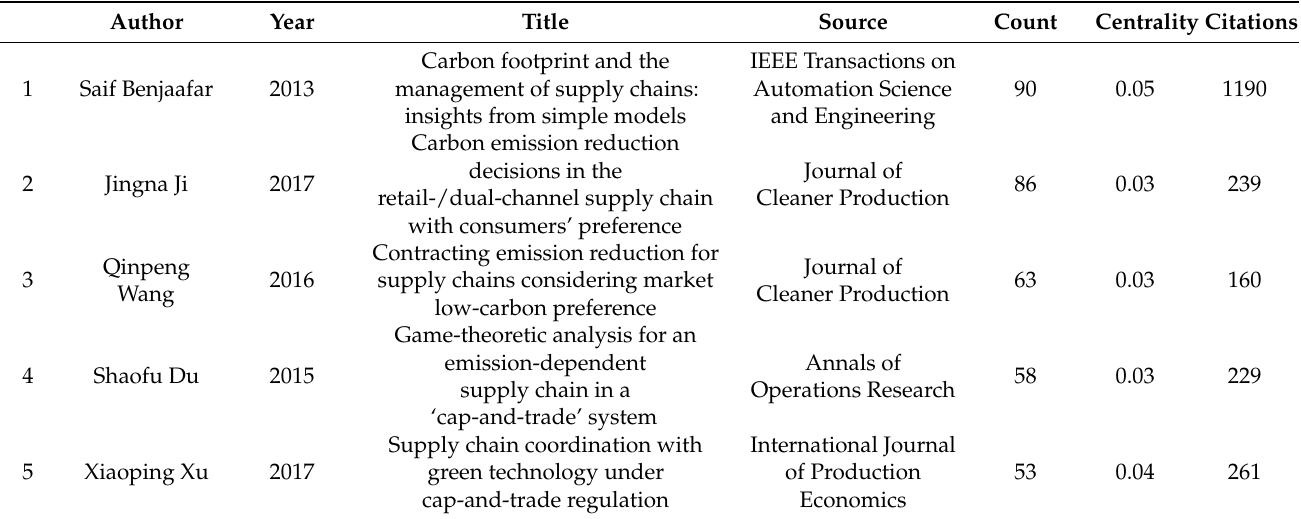
Table 3. Top five co-citation